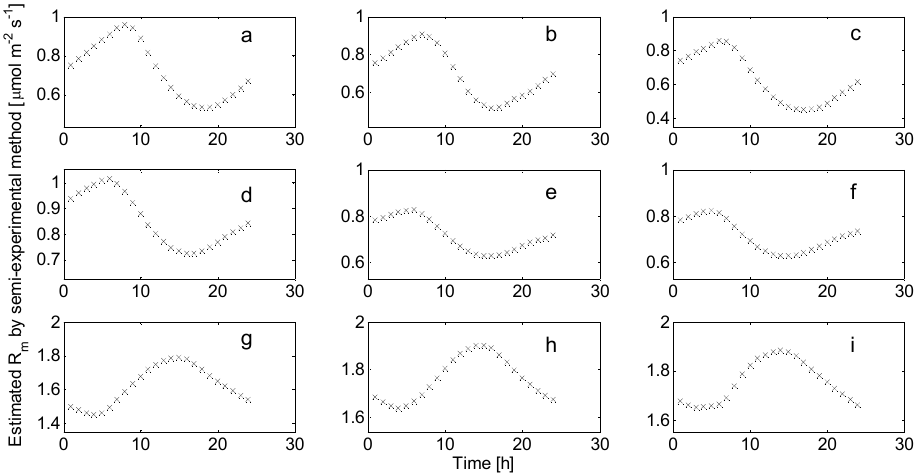
Figure 6. Isolated R m by semi ‐ experimental method ( a – c : saline desert; d – f : abandoned farmland; g – i : oasis farmland).